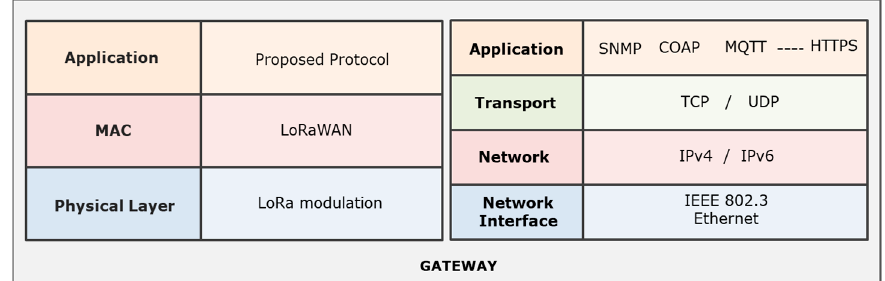
Figure 4. Protocol